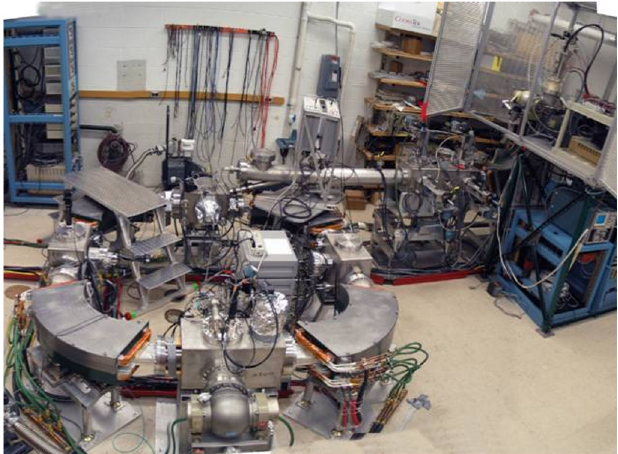
FIG. 1. (Color) Small isochronous